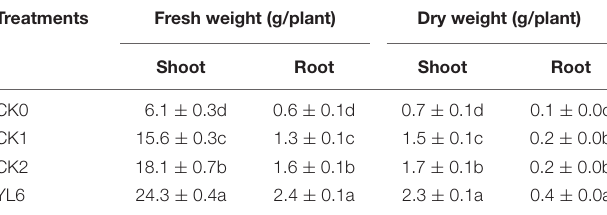
TABLE 2 | Effects of YL6-GFP on the biomass of Chinese cabbage under field